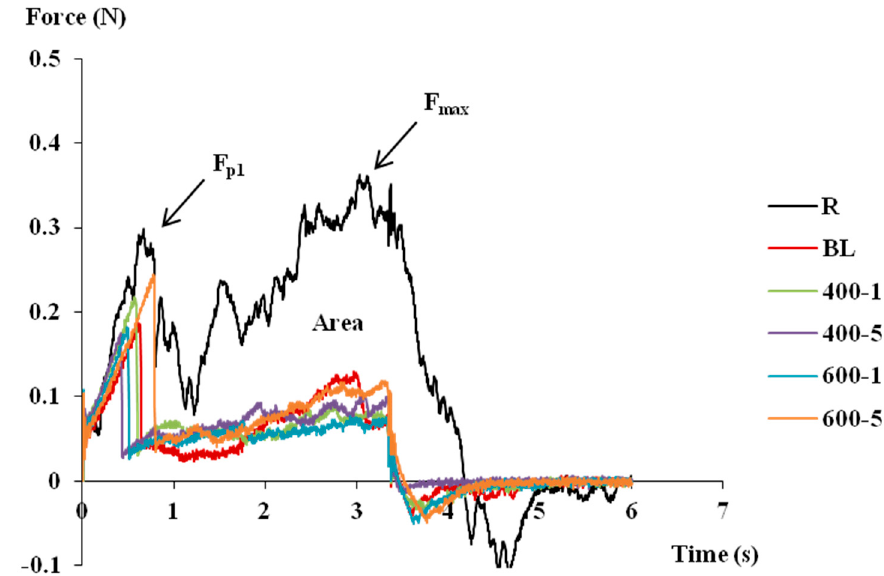
Figure 3. Texture analysis profiles of raw and treated blueberries obtained by puncture test. Abbreviations: R = raw or untreated; BL = blanched; 400-1 = HHP at 400 MPa for 1 min; 400-5 = HHP at 400 MPa for 5 min; 600-1 = HHP at 600 MPa for 1 min; 600-5 = HHP at 600 MPa for 5 min; F P1 = maximum force first peak; F max = absolute maximum force; Area = area under the force / time